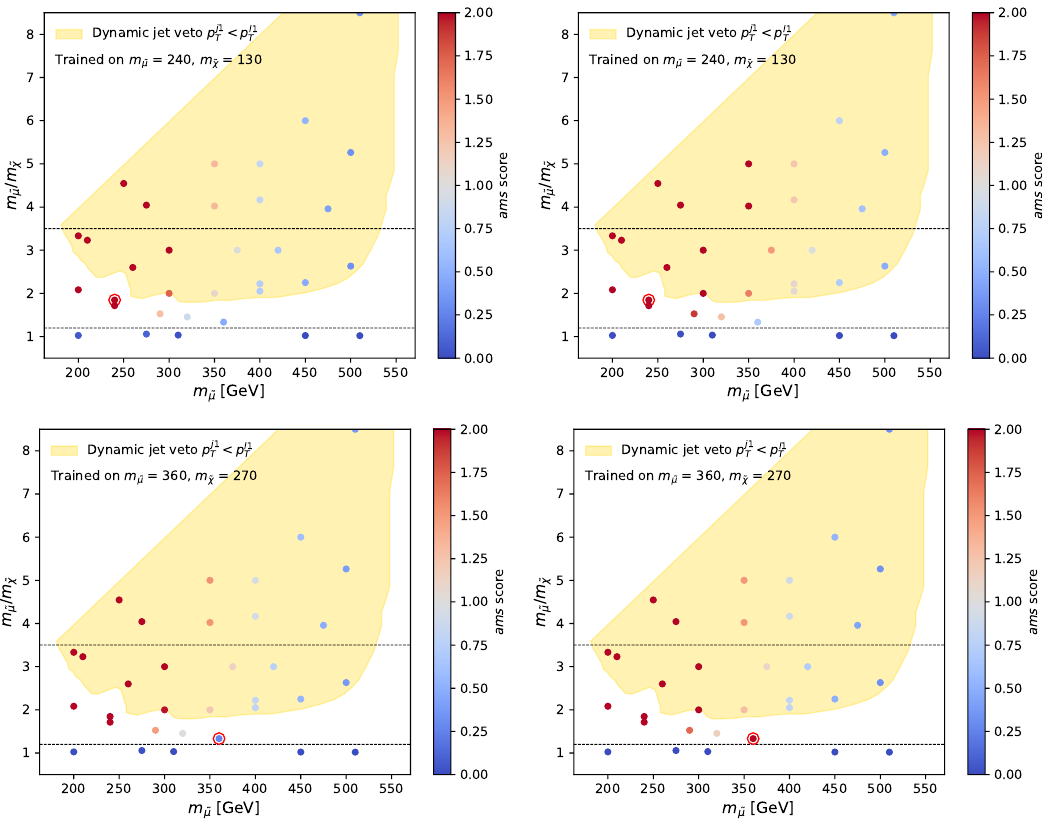
Figure 6 . Comparison of the ‘all features’ case (left) with that of no ratios (right), showing better reach (top line) and better performance on the training benchmark (bottom